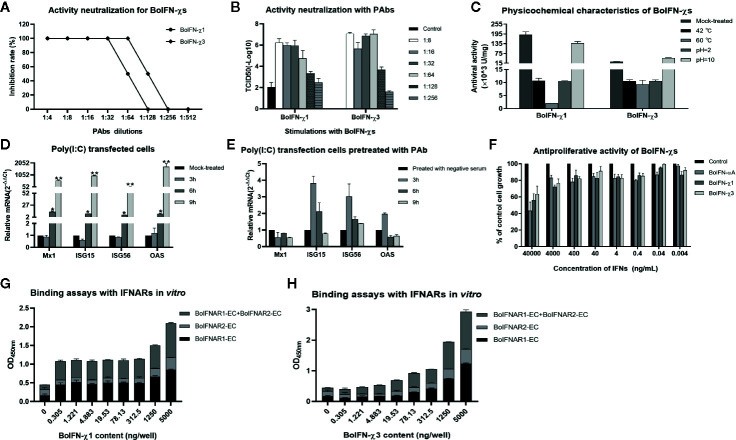
Biologic characteristics of BoIFN-χs. Neutralization of antiviral activity with PAbs against BoIFN-χs with CPE (A) and TCID50 measurement (B). Serial dilution of inactive PAbs against BoIFN-χs were incubated with BoIFN-χs at 37°C for 2 h, and then, the mixtures were centrifuged for collection of supernatant and deterimination of the CPE, or the above cells were collected for further measurement of the TCID50. (C) Sensitivity to pH and temperature of BoIFN-χs. (D) qPCR of ISGs in BL cells with poly(I:C) transfection. (E) qPCR of ISGs in BL cells with poly(I:C) transfection after PAbs against BoIFNχs pretreatment. BL cells were pretreated with inactive PAbs against BoIFNχs for 2 h, and poly(I:C) (1 μg/mL) was transfected in the cells for another 3, 6, or 9 h, and then, the cells were collected for qPCR. The preimmune serum was used as control. (F) Antiproliferative activity of BoIFN-χs in MDBK cells. Relative proliferation was determined as a percentage of the control (0 μg/mL). (G) ELISA for the binding ability of BoIFN-χ1 to BoIFNAR. (H) ELISA for the binding of BoIFN-χ3 to BoIFNAR. Data are the mean ± SD (n = 3) of one representative experiment. *P < 0.05, **P < 0.01.